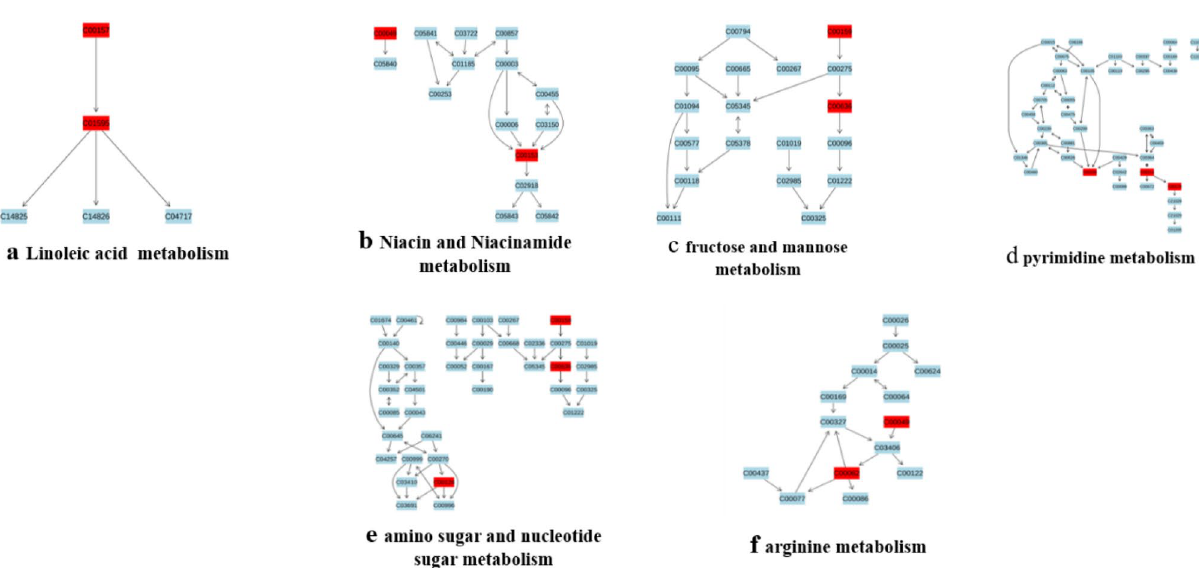
Figure 8. Target metabolic pathways involved in differential metabolites of rat myocardial samples. Red is the potential marker of the pathway involved in this study; Blue is not in the metabolites of this